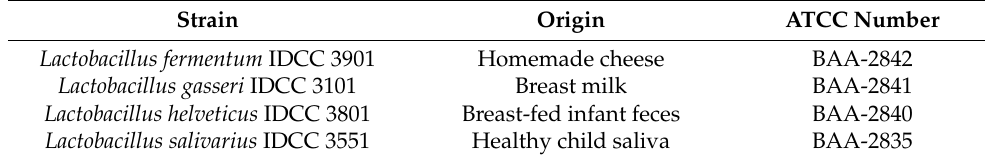
Table 1. Probiotic strains used in this study.